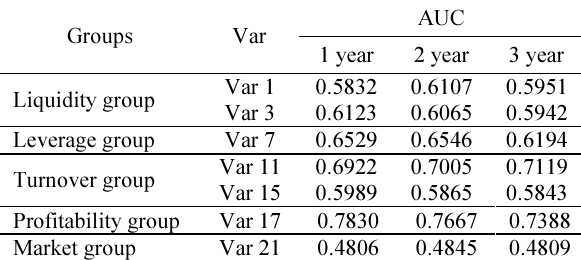
Table 4. The selected financial ratios for multivariable logit